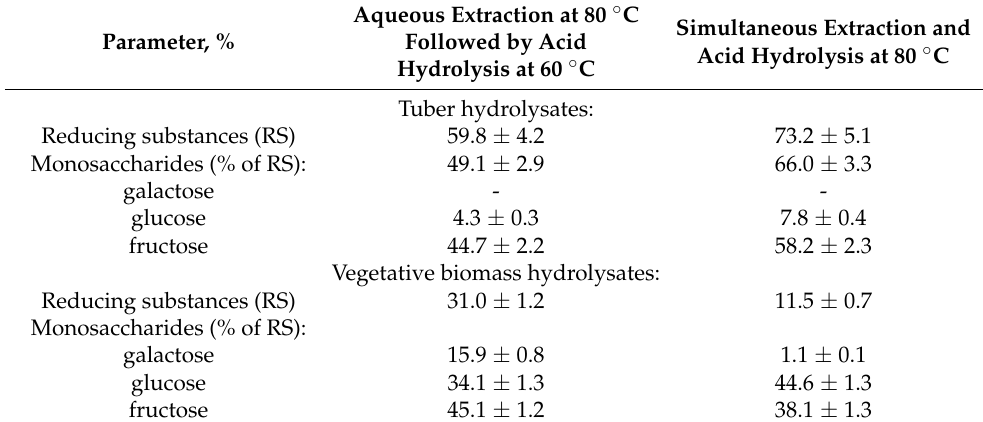
Table 2. Composition of hydrolysates of the tubers and vegetative biomass of Jerusalem artichoke cv. Interes under different procedures of